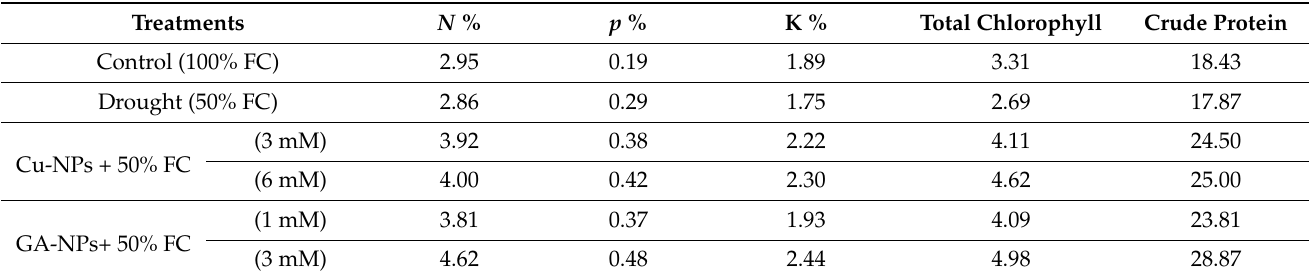
Table 6. The effect of Cu-NPs and GA-NPs on mineral element content (%matter) in soybean leaves under drought stress. Each value is the average of both seasons.